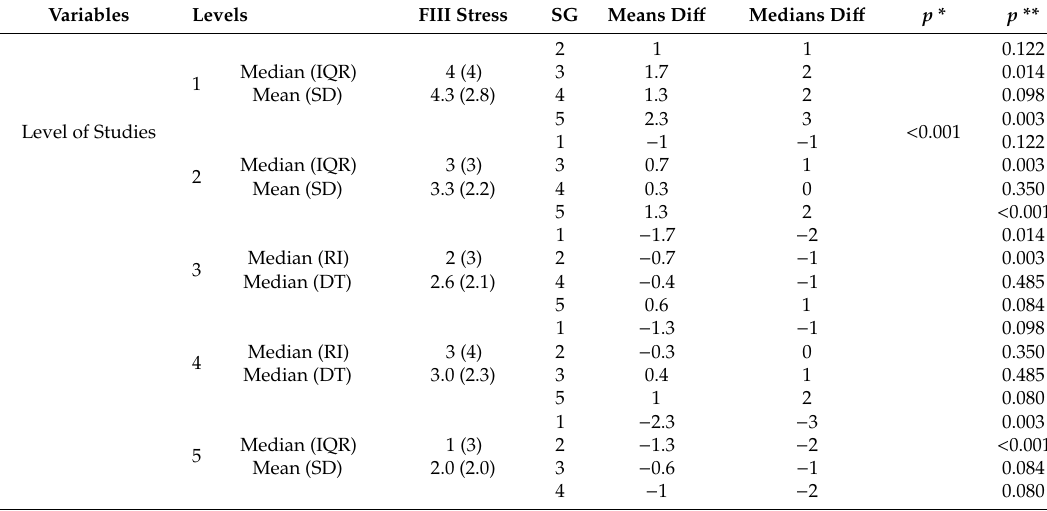
Table 5. Comparison of Factor III “Stress” according to the level of studies, relationship and hours dedicated to